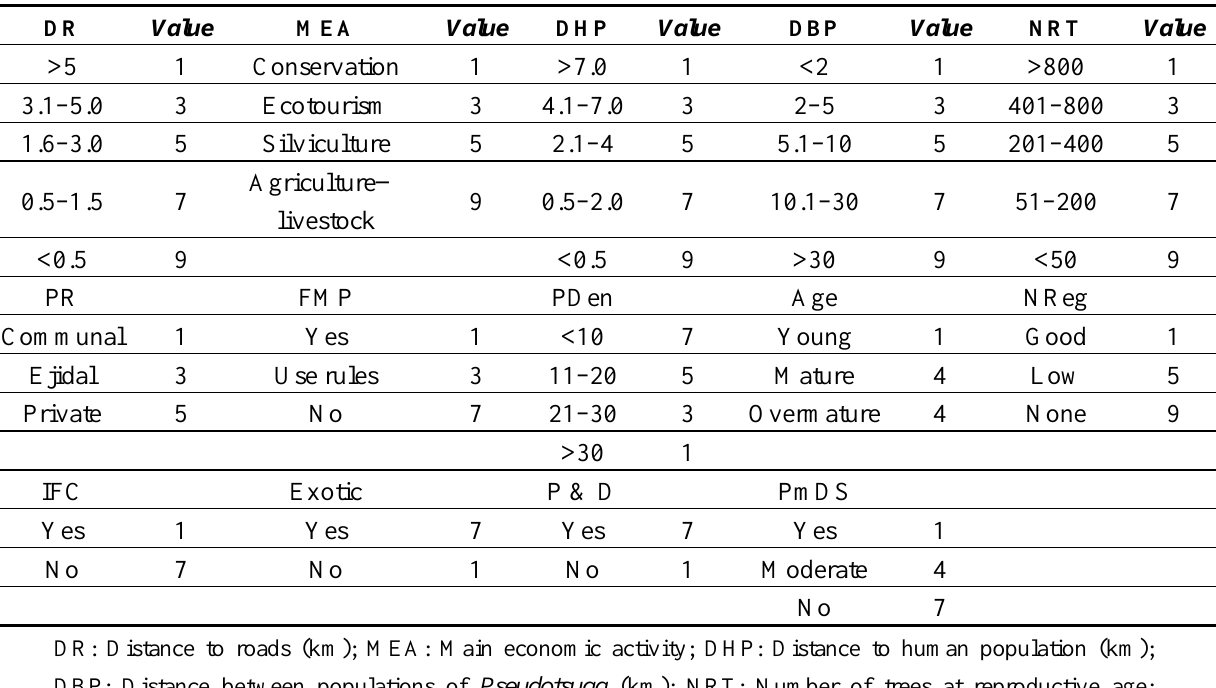
Table 1. Standardized values for the sub-criteria used to determine the risk of 29 populations of Pseudotsuga menziesii in central